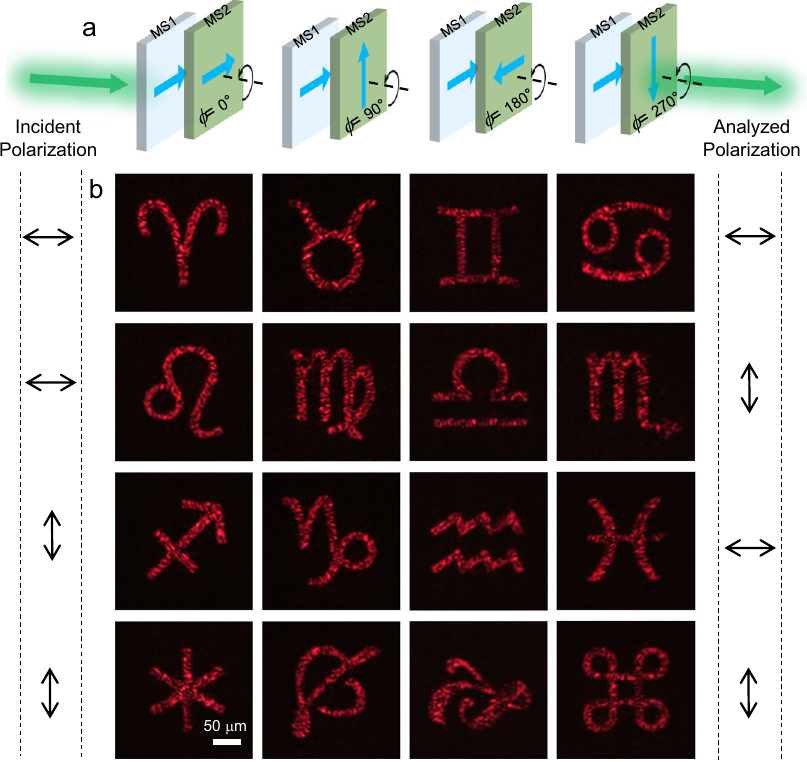
Fig. 4 | Bilayer metasurface for polarization-rotation multiplexed multi- functional holography. a Schematic of the two layer metasurfaces with different rotation angle ϕ = 0°, 90°, 180°, and 270°. The arrows on the metasurfaces show therelativerotationanglesbetweenthetwolayers. b Measuredholographicimages under the four different combinations of the incident and analyzed polarizations